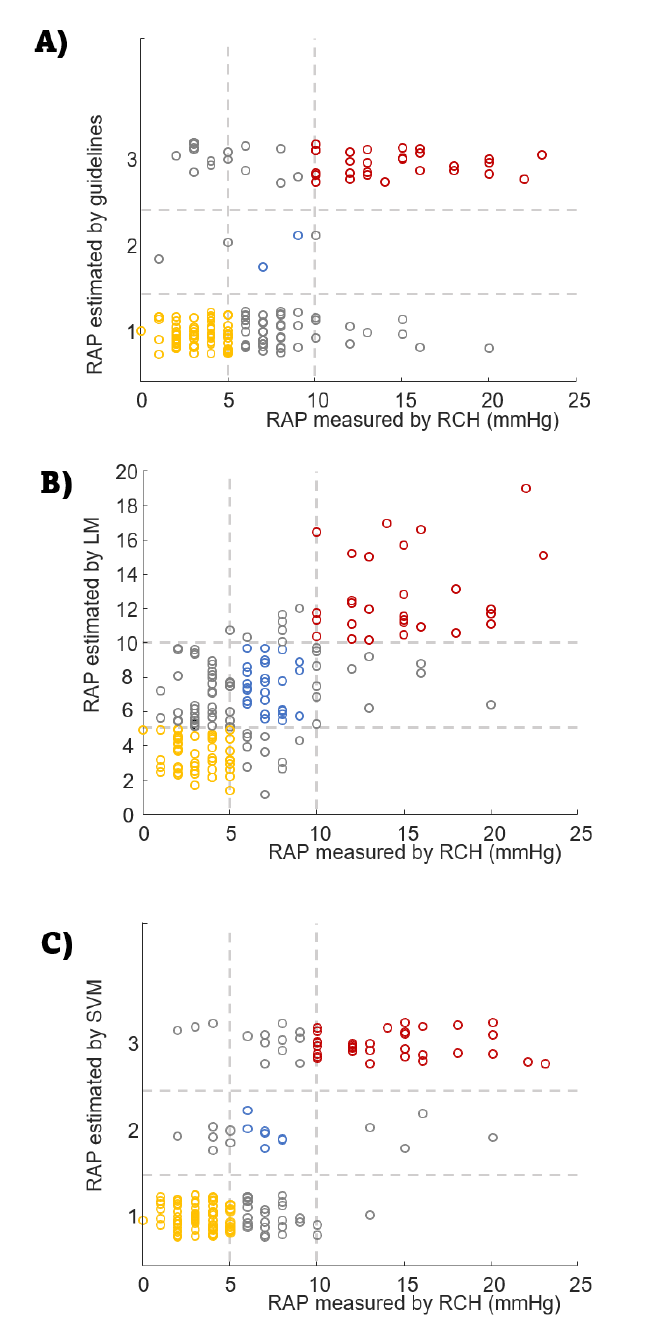
Figure 4. Classification of the subjects obtained by ( A ) guidelines, ( B ) LM, and ( C ) SVM. To avoid superposition of different cases, the estimated values are randomly shifted around the categorical output provided by guidelines and SVM (on the other hand, the continuous output of the linear model is shown in ( B ) as a scatter plot). RAP classes are: 1 = low, 2 = intermediate, 3 = high. LM: linear model; RAP: right atrial pressure; RHC right heart catheterization; SVM: support vector